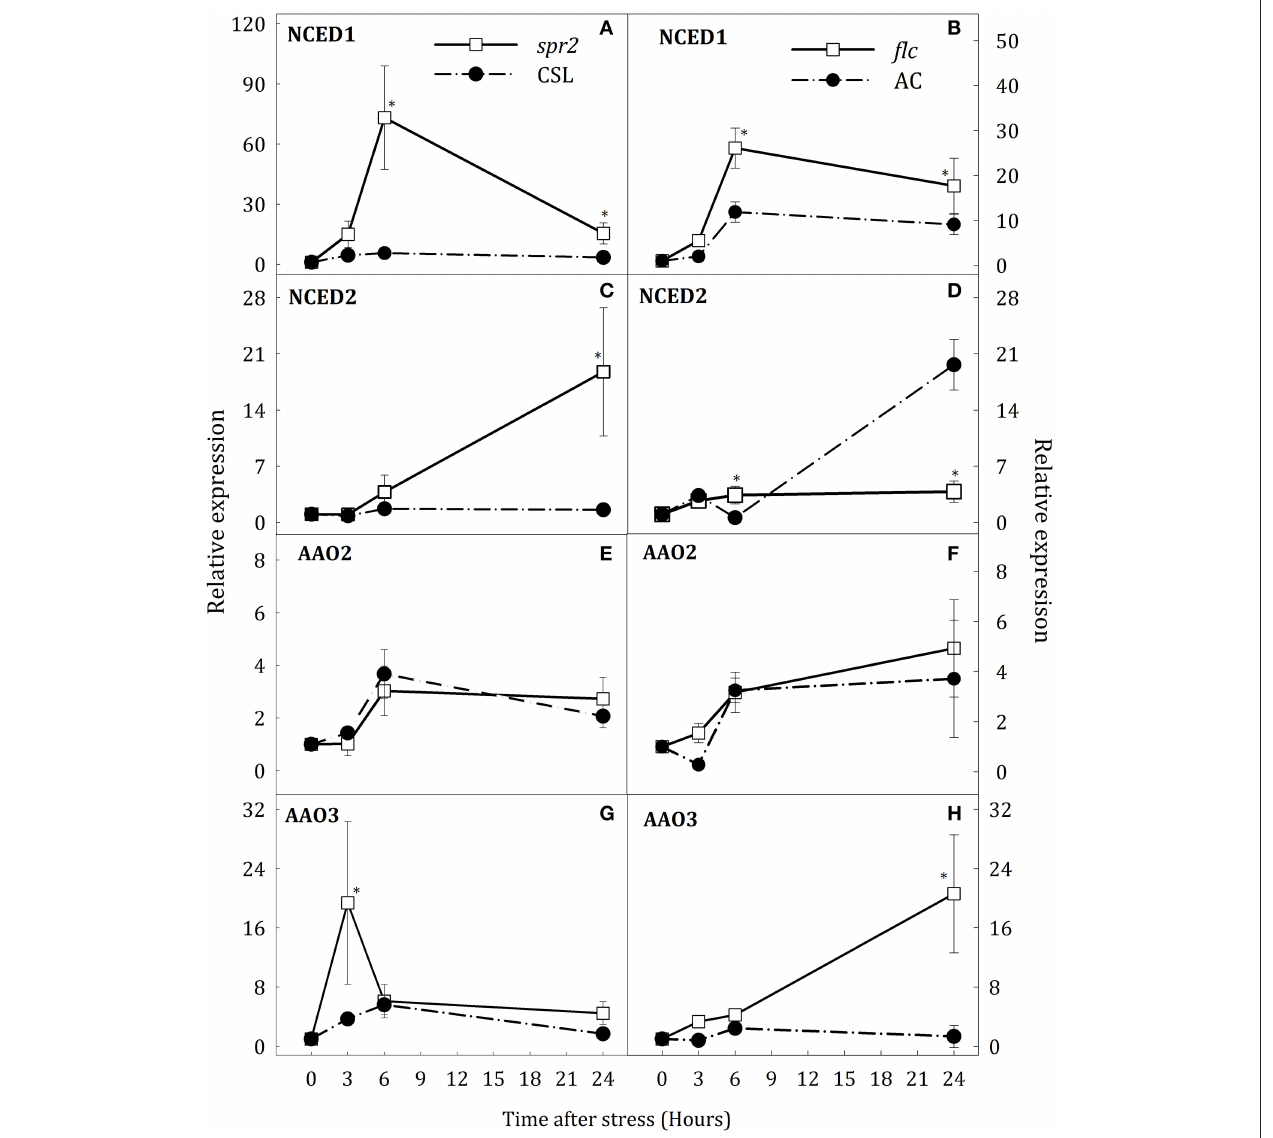
FIGURE 4 | Relative expression of NCED1 (A,B), NCED2 (C,D), AAO2 (E,F), and AAO3 (G,H) in leaves of Solanum lycopersicum [WT (CSL and AC, black circles) and mutants ( spr2 and flc , white square)] under control ( t = 0 ) and water-stress conditions. Data are mean values ± standard deviation of three independent determinations. Asterisks denote statistical difference with respect to WT at p ≤ 0.05